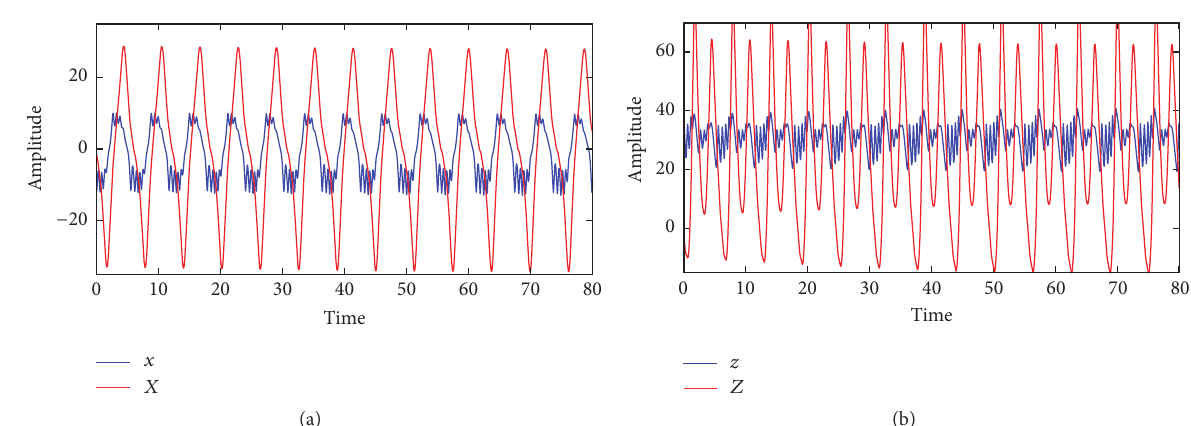
Figure 4: Fast ( 𝑥 and 𝑧 ) and slow ( 𝑋 and 𝑍 ) variables for the case of 𝑐 = 1.0